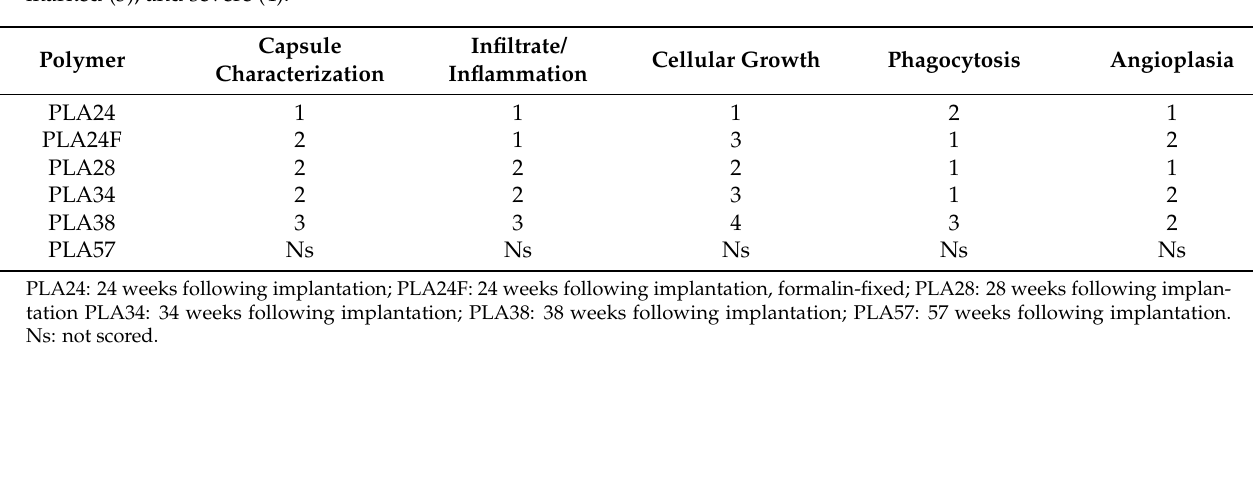
Table 1. Score classification of the histopathological lesions in the implant samples at each surgical removal time of a horse implanted with six polymers of poly(lactic acid) (PLA). Intensity of lesions was classified as mild (1), moderate (2), marked (3), and severe